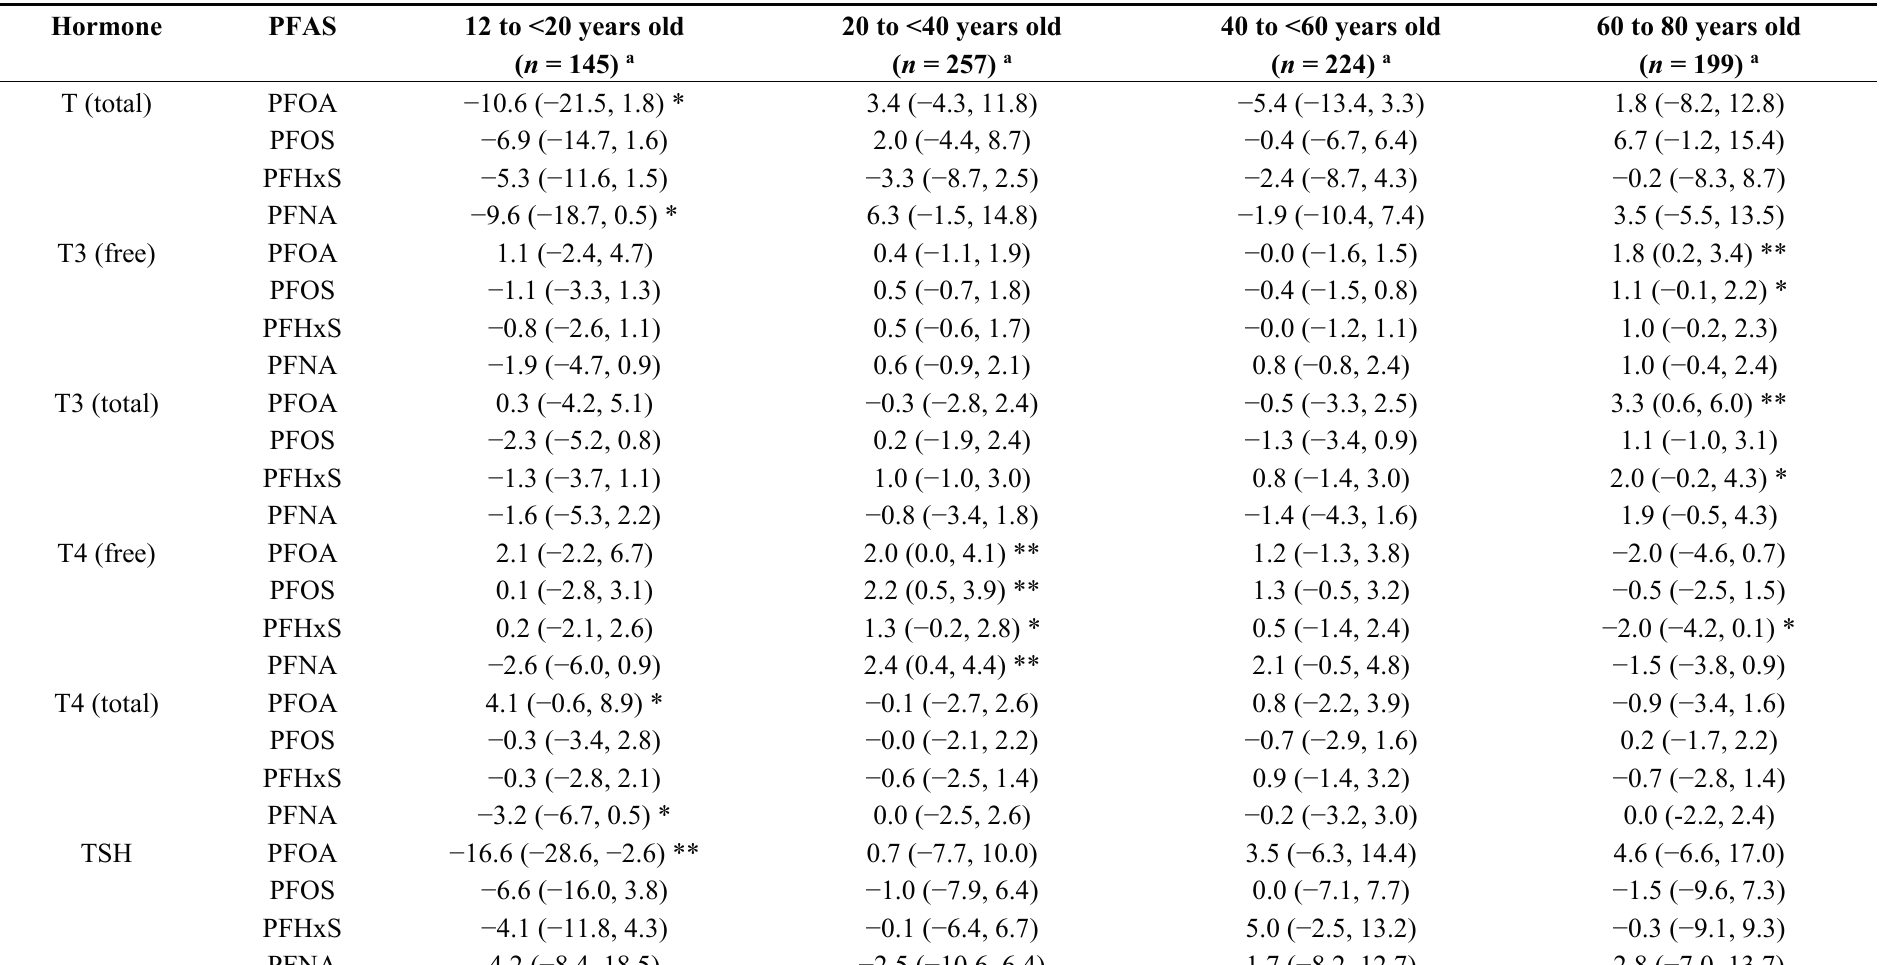
Table 5. Percent change (95% CI) in serum hormone concentration associated with a doubling (100% increase) in serum PFAS concentration among females from NHANES 2011–2012 (adjusted